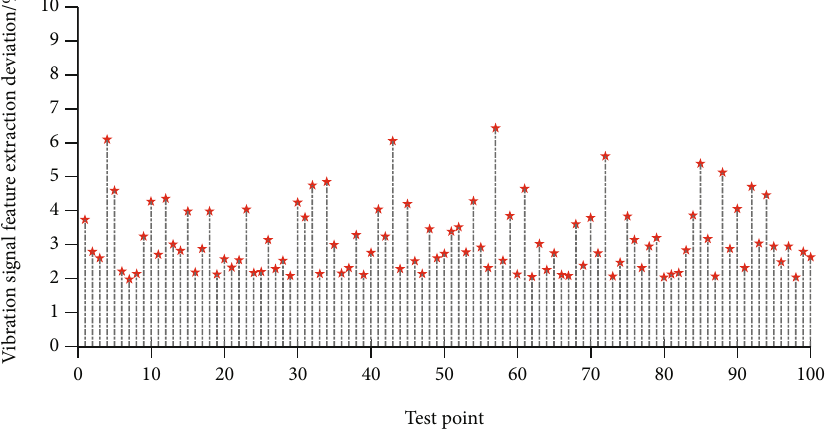
Figure 5: Interpolated line graph of vibration signal feature extraction.